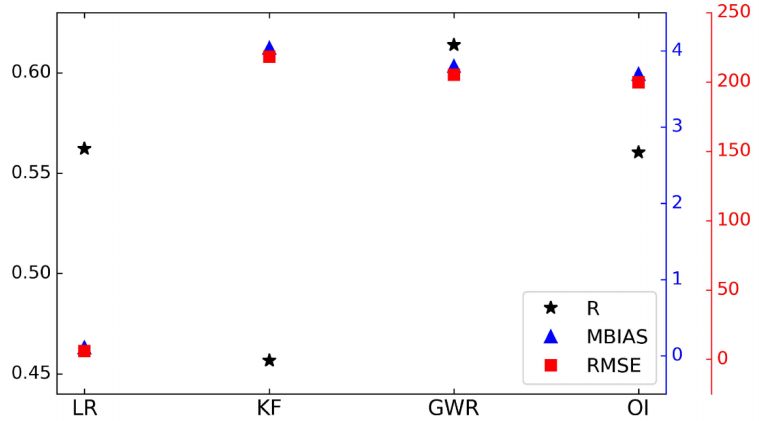
Figure 5. Fusion data accuracy analysis of four methods.